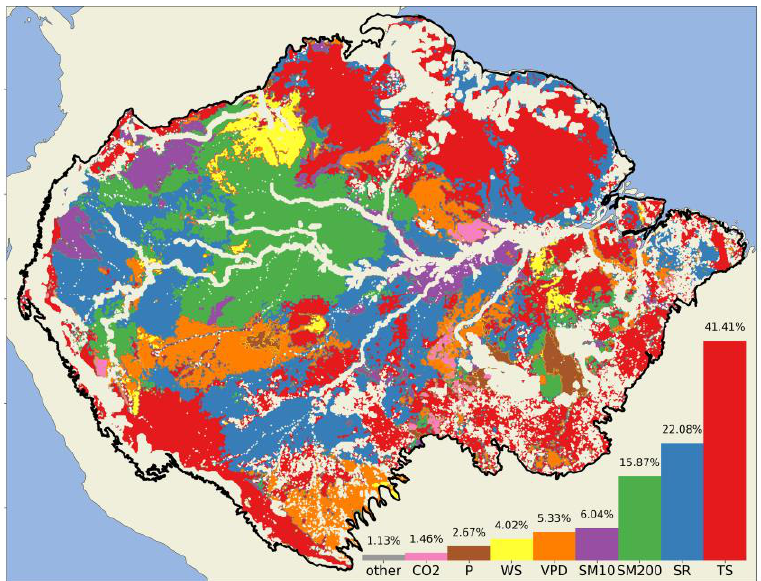
Figure 6. Spatial variability of primary drivers for each pixel with a resolution of 0.05° × 0.05°. The heights of the bars indicate the percentage of the cells occupied by the corresponding drivers. Soil indicates the combination of CLAY, TN, and TP.